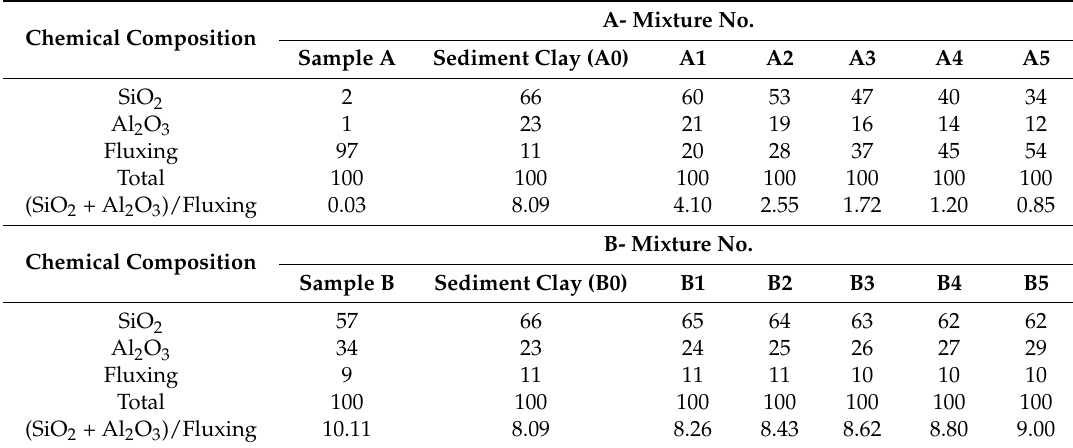
Table 3. Chemical composition ratio of the test materials.